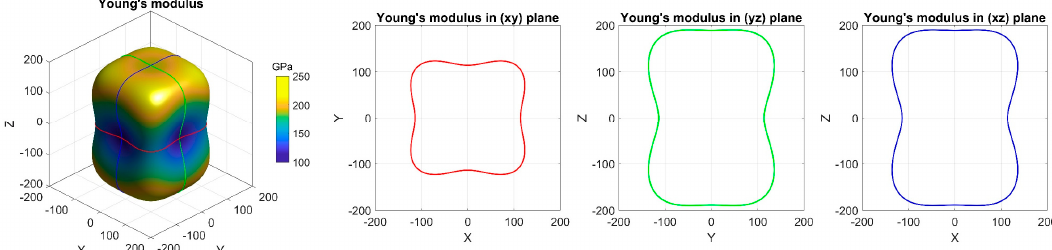
Figure 11. The calculated directional dependent Young’s modulus for the full Heusler compound Pd 2 CoAl in L2 1 -type tetragonal structure.